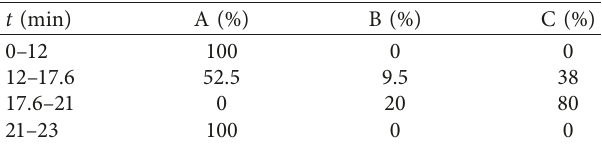
Scheme 1: Synthetic food dyes used in this study. (a) Tartrazine, E 102, CI 19140. (b) Allura Red AC, E 129, CI 16035. (c) Sunset Yellow FCF, Table 1: Optimized gradient program for the separation of four dyes by HPLC-UV, at a flow rate of 1.0mL min − 1